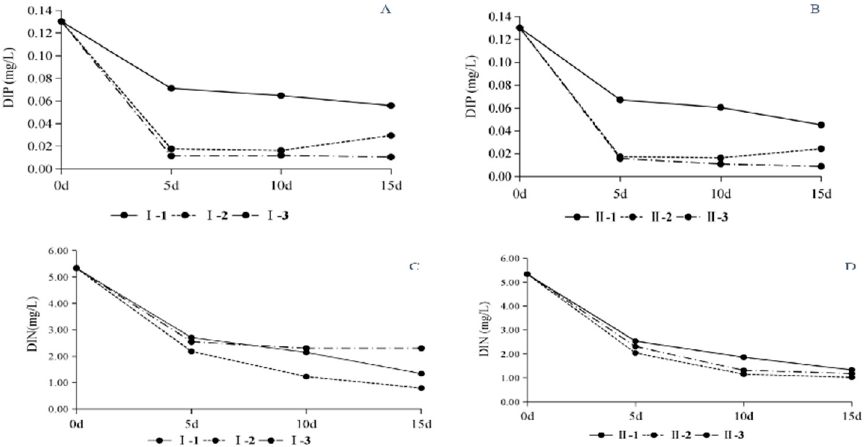
Figure 10. Effect of different algal inhibition methods on ( A ) dissolved inorganic phosphorus (DIP) and ( C ) dissolved inorganic nitrogen (DIN) in sediment; and effect of different algal inhibition methods on ( B ) DIP and ( D ) DIN in sediment (added G. catenatum cyst ).